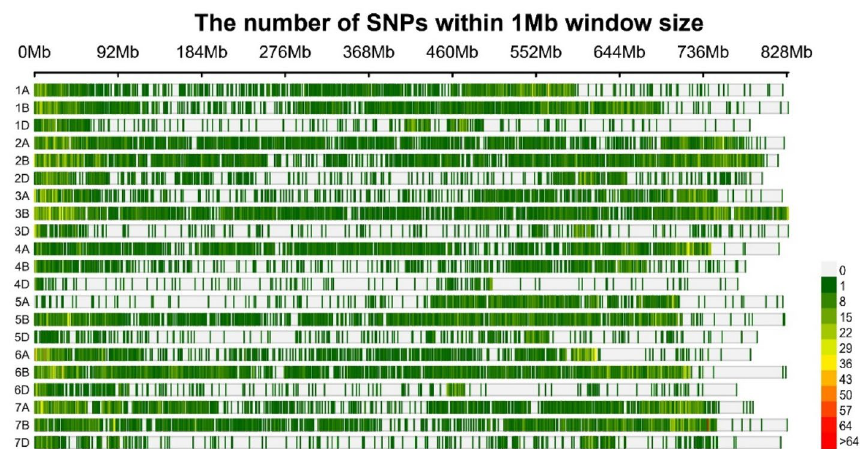
Figure 3. Density plot by different chromosomes in total Iranian bread wheat cultivars and